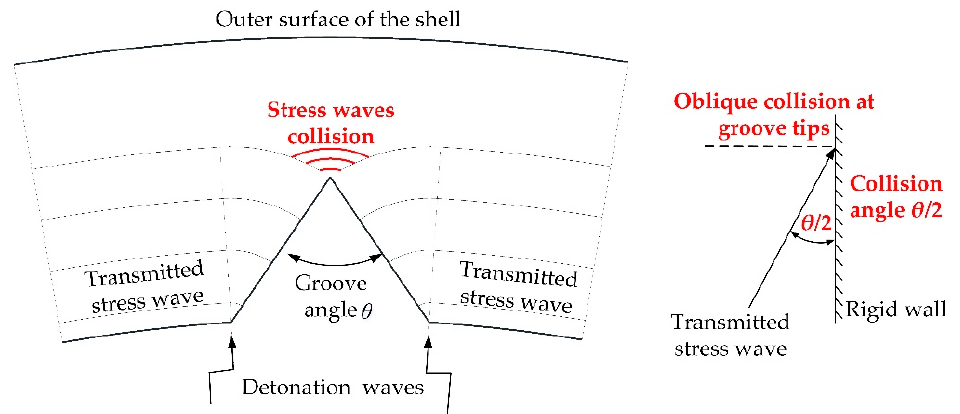
Figure 2. Collision of the transmitted waves at groove tips and oblique collision of the shock wave on the rigid